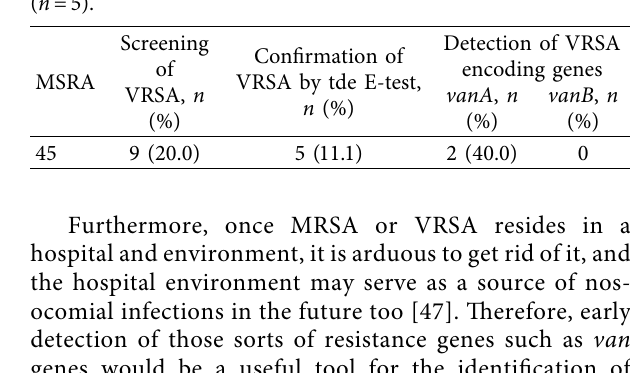
Figure 1: MIC result of vancomycin against MRSA isolates using an E-test strip (MIC; minimum inhibitory concentration, VSSA, vancomycin-sensitive S. aureus ; VISA, vancomycin-intermediate S. aureus ; VRSA, vancomycin-resistant S. aureus ; and ZOI, zone of inhibition). Table 5: Molecular screening of VRSA for vanA and vanB